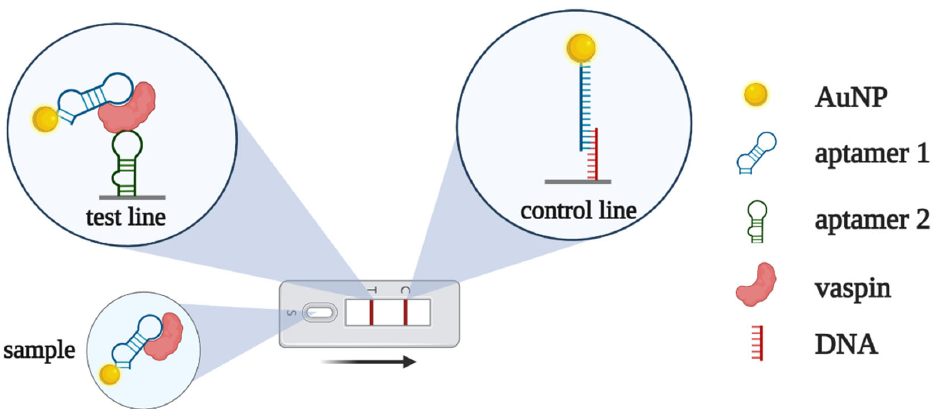
Figure 12. Lateral flow assay for vaspin detection based on two aptamers [62]. The complex of vaspin and AuNP-modified aptamer 1 binds with aptamer 2 at the test line, resulting in an increase in AuNP concentration and red coloring. In the absence of vaspin, AuNP-aptamer 1 binds the complementary DNA and provides red coloring at the control